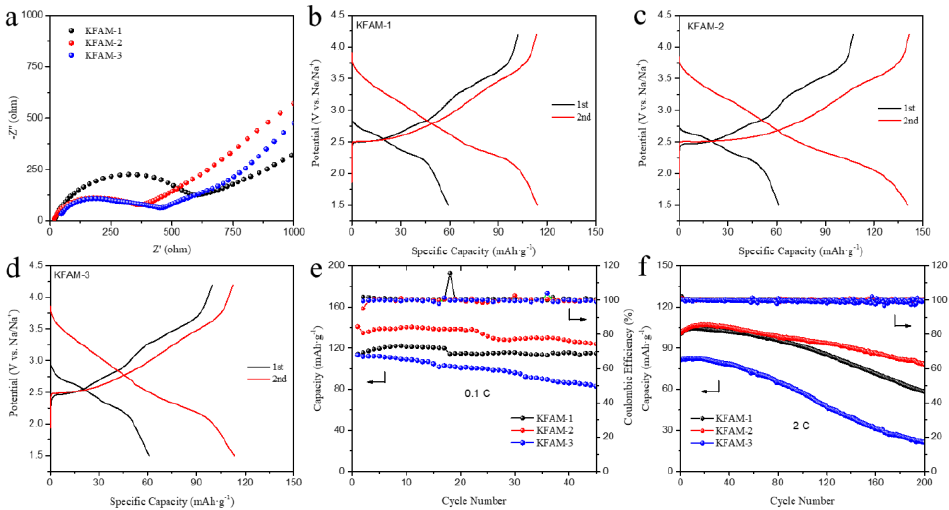
Figure 4. ( a ) EIS plots of KFAM-X. The 1st and 2nd charge–discharge curves of ( b ) KFAM-1, ( c ) KFAM-2 and ( d ) KFAM-3. Cyclic life of KFAM-X at ( e ) 0.1 and ( f ) 2 C.